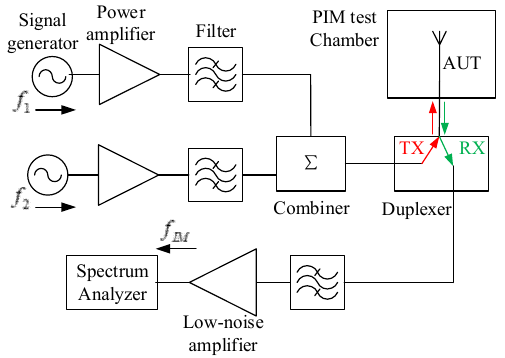
Figure 1. Passive intermodulation (PIM) measurement architecture.